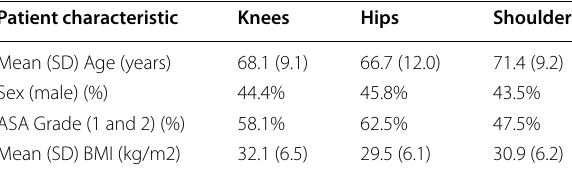
Table 2 Summary of patient characteristics by joint Patient characteristic